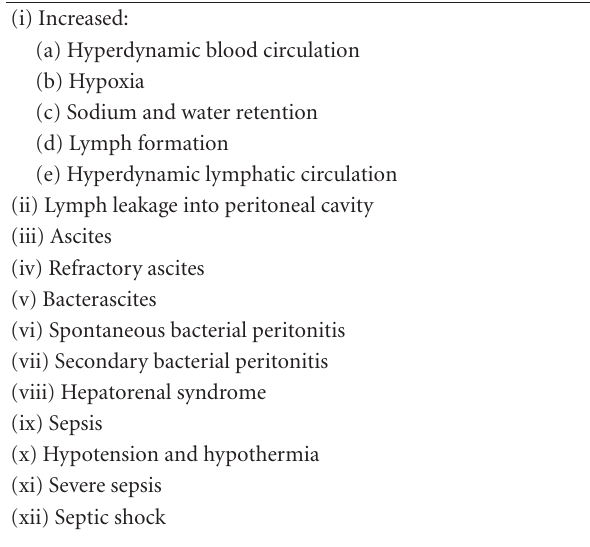
Table 2: Characteristics of progressive portal hypertensive syn-